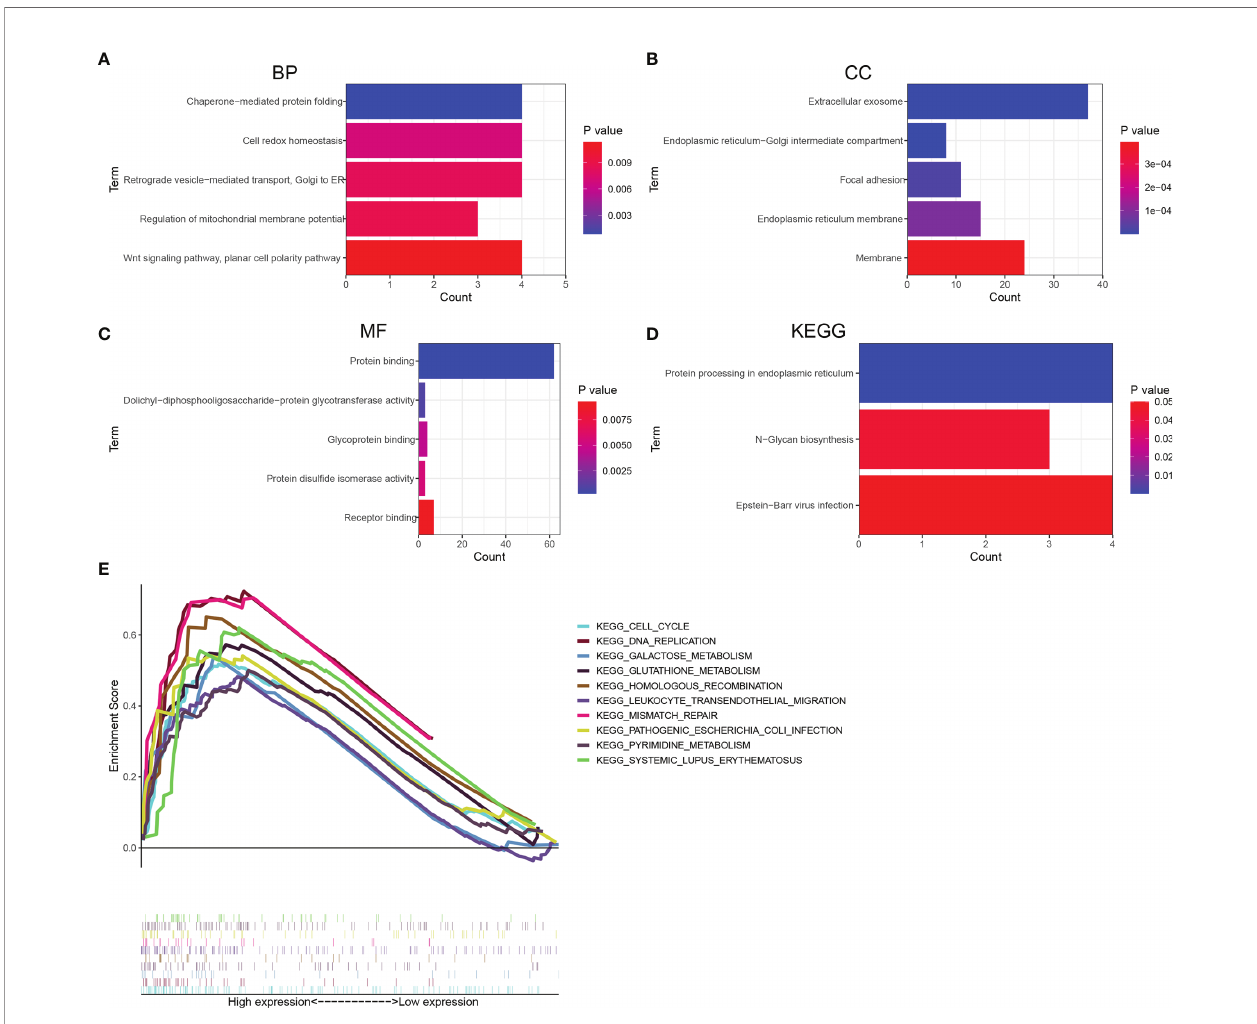
FIGURE 10 | Functional enrichment analyses for top 100 co-expression genes of KDELR1. (A – C) Top 5 GO terms of BP, CC, and MF. (D) Three KEGG pathways. (E) gene set enrichment analysis revealed potential associations between KDELR1 and several metabolism-associated